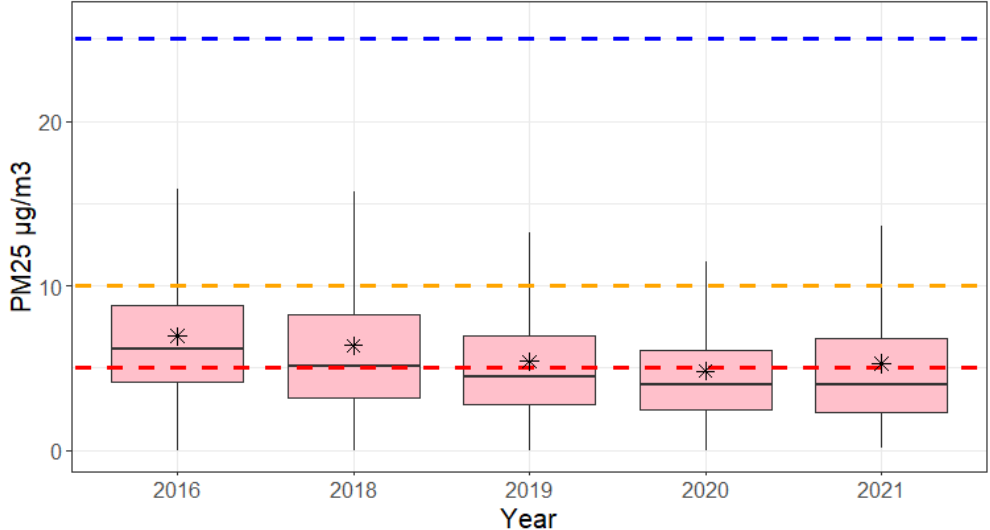
Figure 5. Boxplot of the measured annual median (black line), interquartile ranges and mean (stars) concentration of PM 2.5 2016, 2018–2021 at various ports of Helsinki. The blue line is the Finnish/EU limit of 25 µg/m 3 , which was in force during the studied years. The red line is the WHO 2021 recommended limit of 5 µg/m 3 and the orange line the EU proposal of 10 µg/m 3 .